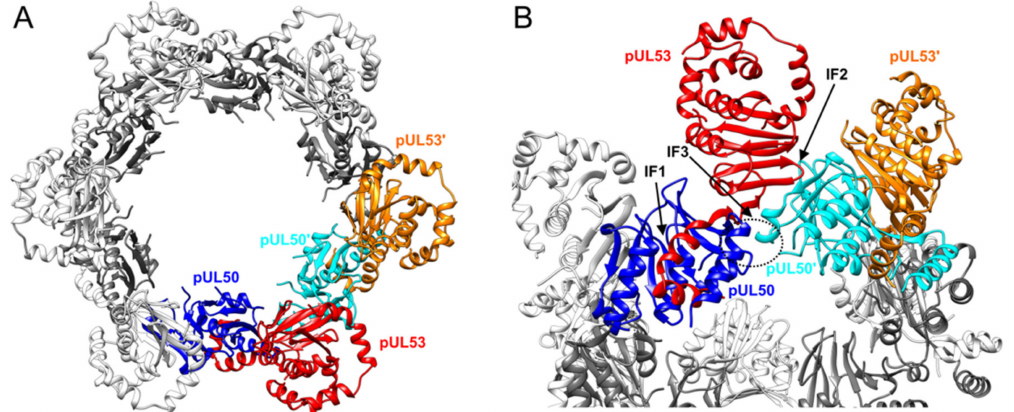
Figure 5. Crystal structure of the hexameric HCMV NEC. ( A ) Top view on the NEC highlighting two adjacent pUL50–pUL53 heterodimers in color. For the remaining building blocks, pUL50 and pUL53 are shown in grey and white, respectively. ( B ) Enlargement of the interface region. The most prominent interaction within the pUL50–pUL53 heterodimer is the hook- into-groove interface (labeled as IF1). Between adjacent pUL50–pUL53 heterodimers, the interfaces IF2 (pUL53–pUL50 (cid:48) ) and IF3 (pUL50–pUL50 (cid:48) ) are observed. The latter interface is highlighted by a dotted circle. The structure was obtained from PDB code